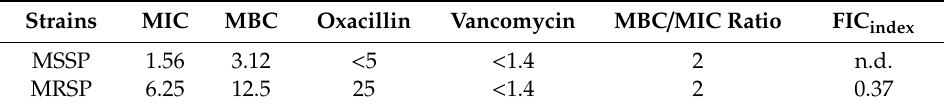
Table 3. MIC, minimum bactericidal concentration (MBC), MBC / MIC ratio, and FIC index values ( µ M) of peptide 8 on selected bacterial strains. N.d. = not determined. Each experiment is the result of three independent experiments performed in triplicate.